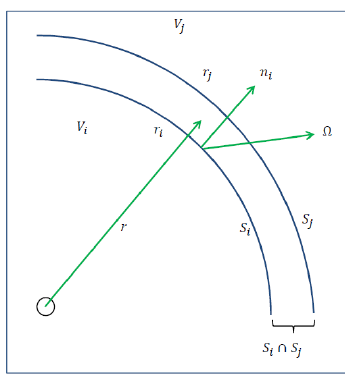
Figure 1. The general scheme of two separated scheme with no connection.